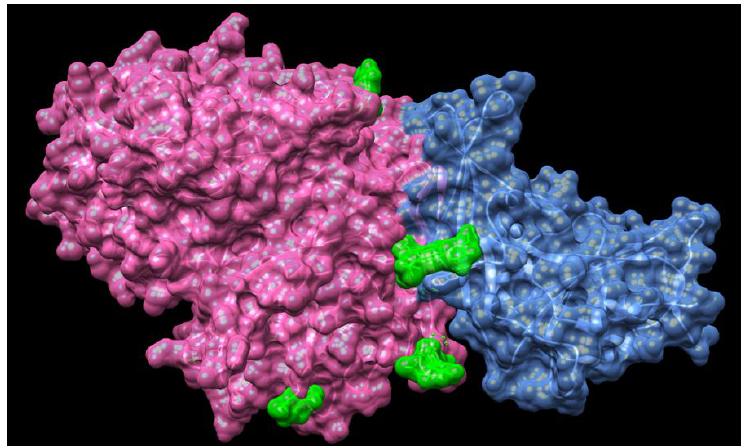
Figure 5. Structures of MERS-CoV spike glycoprotein in complex with sialoside attachment receptors (PDB: 4KR0). MERS-CoV Spike glycoprotein is composed of an N-terminal S1 subunit, which is assembled as four domains (A–D) and controls attachment to dipeptidyl-peptidase 4 (DPP4, the host receptor), and a C-terminal S2 subunit that combines the viral and cellular membranes to initiate infection. Spike glycoprotein is highlighted in pink, DPP4 is highlighted in blue and the ligand Neu5Ac is highlighted in green.